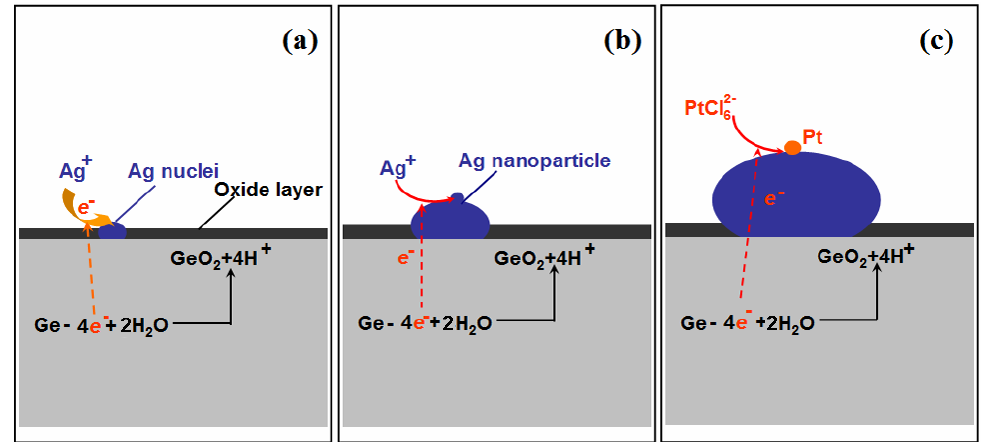
Figure 3. Schematic illustration of the growth process of Ag–Pt NPs on the Ge wafer. ( a ) the formation of Ag nuclei, ( b ) the growth of Ag nanoparticle and ( c ) the formation of Pt nanoparticle on the surface of Ag nanoparticle.